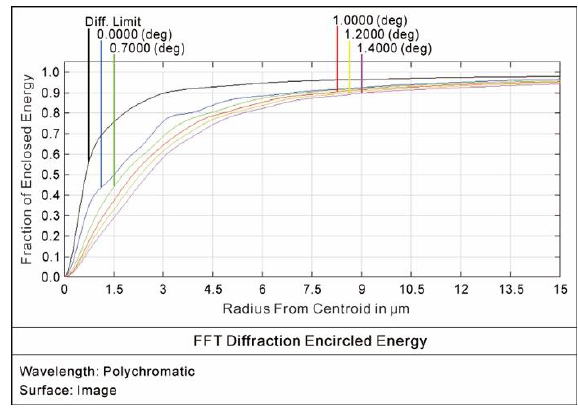
Figure 8. Encircled energy curves.